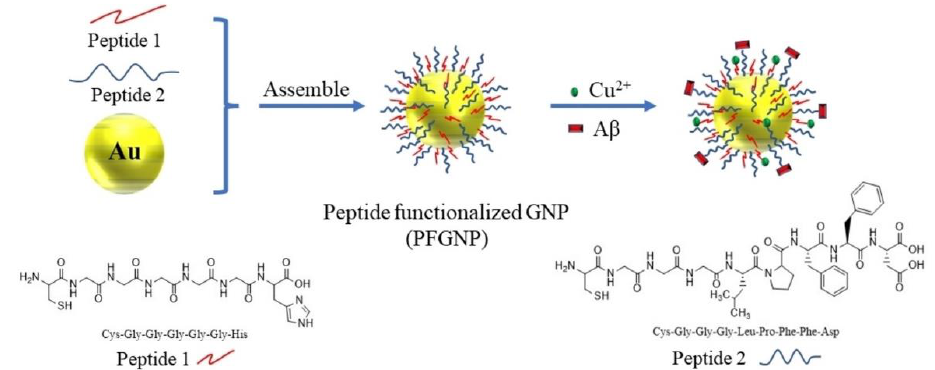
Figure 8. Metal-chelating peptides were used to coat gold NPs and bind Cu 2+ ions to inhibit Aβ fibrillation. Reproduced with permission from [114]. Copyright © 2022 Wiley-VHCA AG, Zurich, Switzerland.